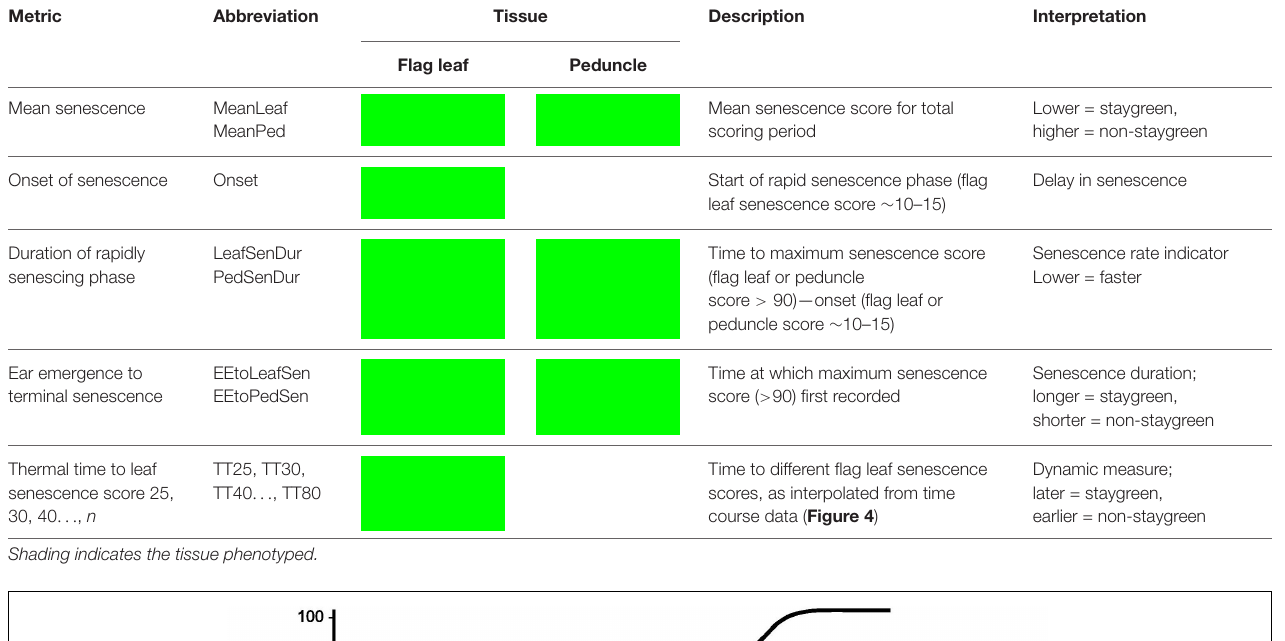
TABLE 3 | Senescence metrics derived for quantification and qualification of time course senescence profiles.